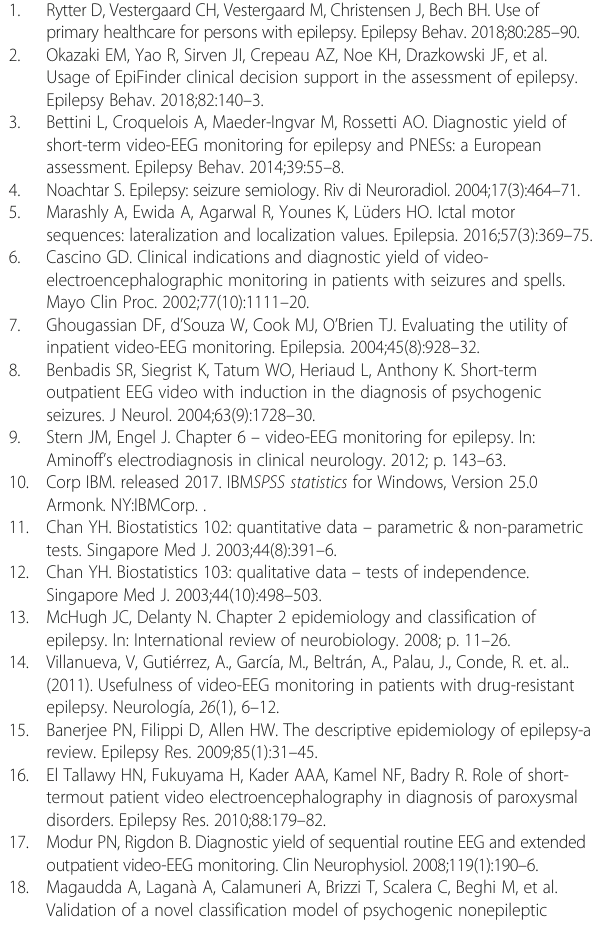
Villanueva et al.